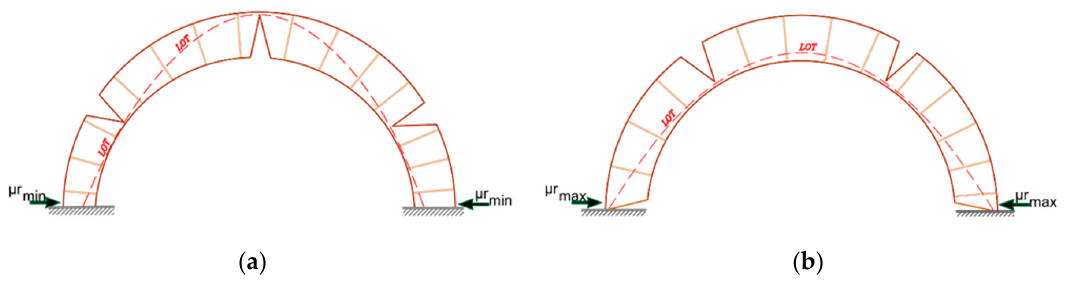
Figure 2. Settlement state: ( a ) minimum horizontal thrust; ( b ) maximum horizontal thrust.